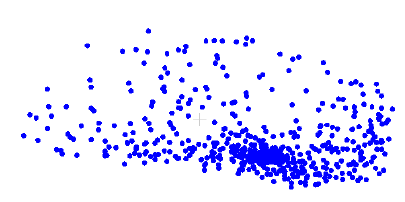
Figure 5. Synthetic vehicle sample generated by 3dAAE trained without data augmentation